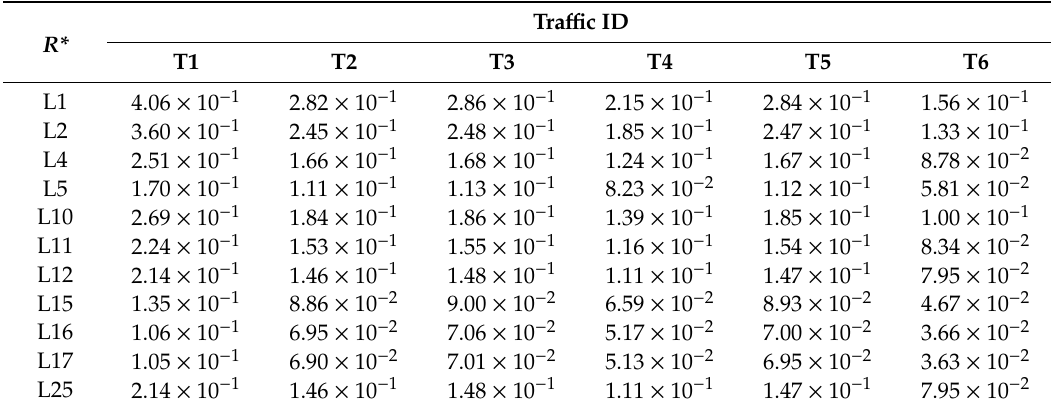
Table 6. Risk of collision for symmetrical layouts.